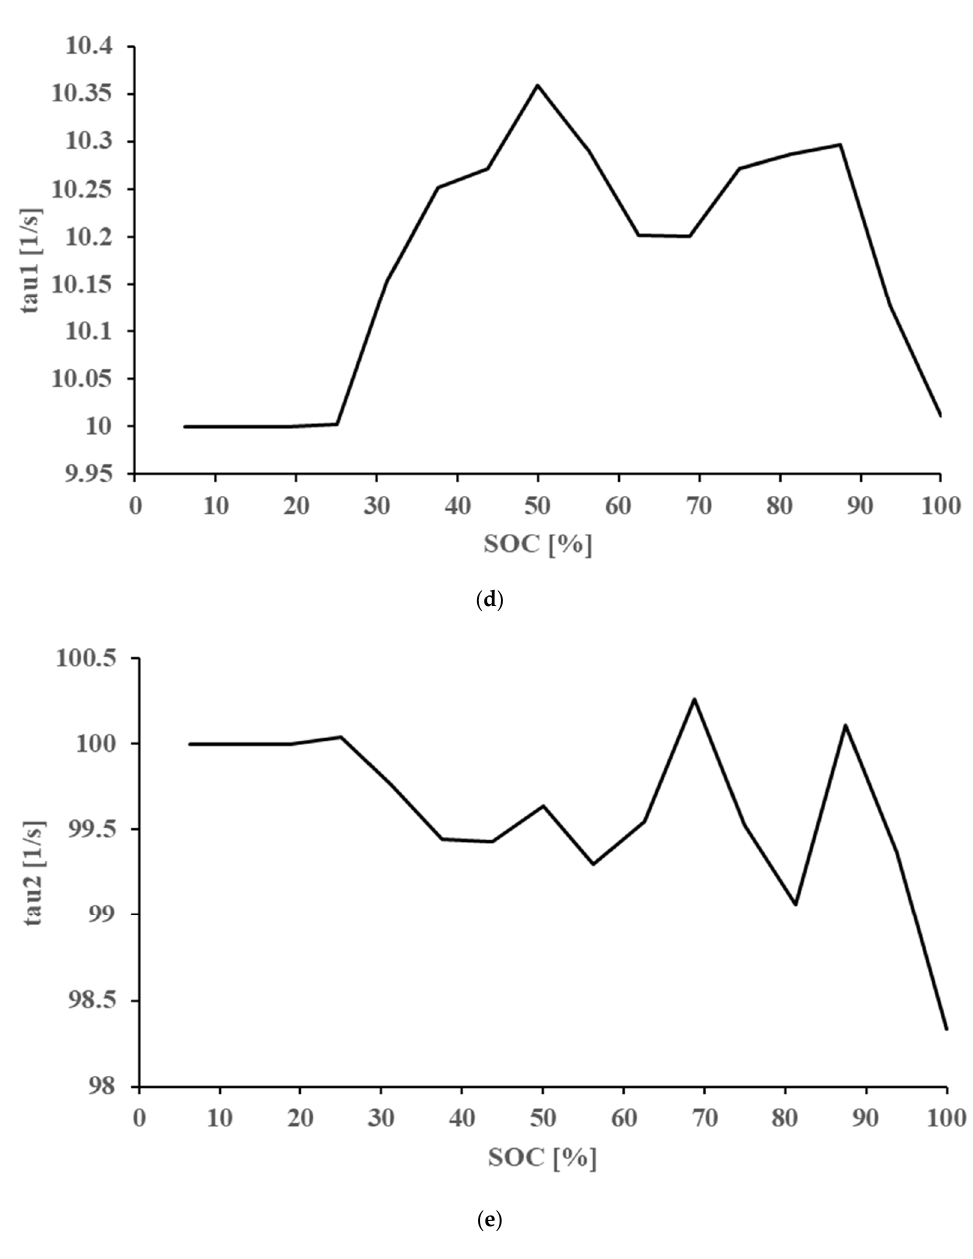
Figure 8. The estimated parameters for second order ECM using HPPC data: ( a ) open circuit voltage, ( b ) static ohmic resistance, ( c ) dynamic constants resistances, ( d ) first time constant and ( e ) second time constant in various state of charges